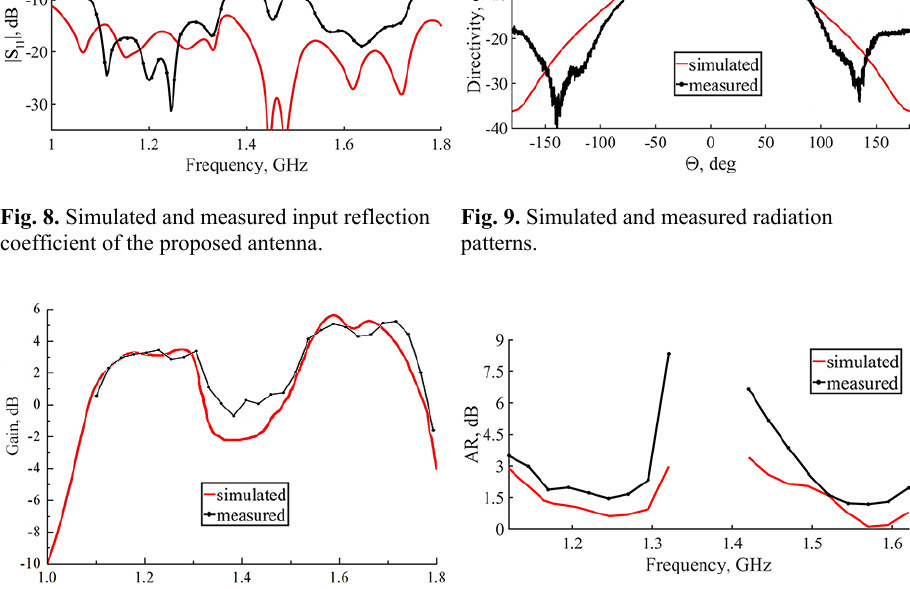
Fig. 11. Simulated and measured